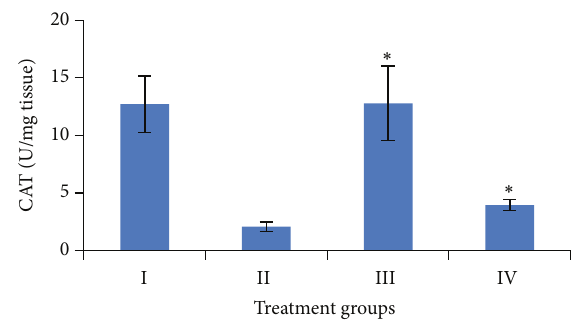
Figure 6: Variations in CAT level after DENA/CCl 4 induced hep- atic carcinogenesis with/without ACE administration. Significance level—normal versus carcinogen treated control; carcinogen treated control versus ACE treated experimental ∗ 𝑃 < 0.001 .